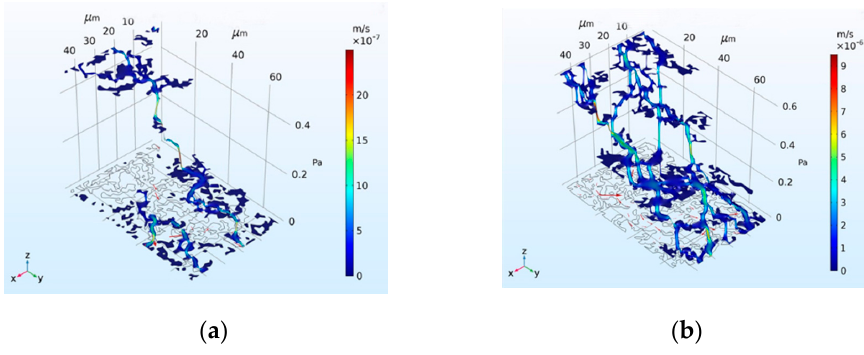
Figure 16. Comparison of pore surface flow rates ( a ) with/( b )without shear.